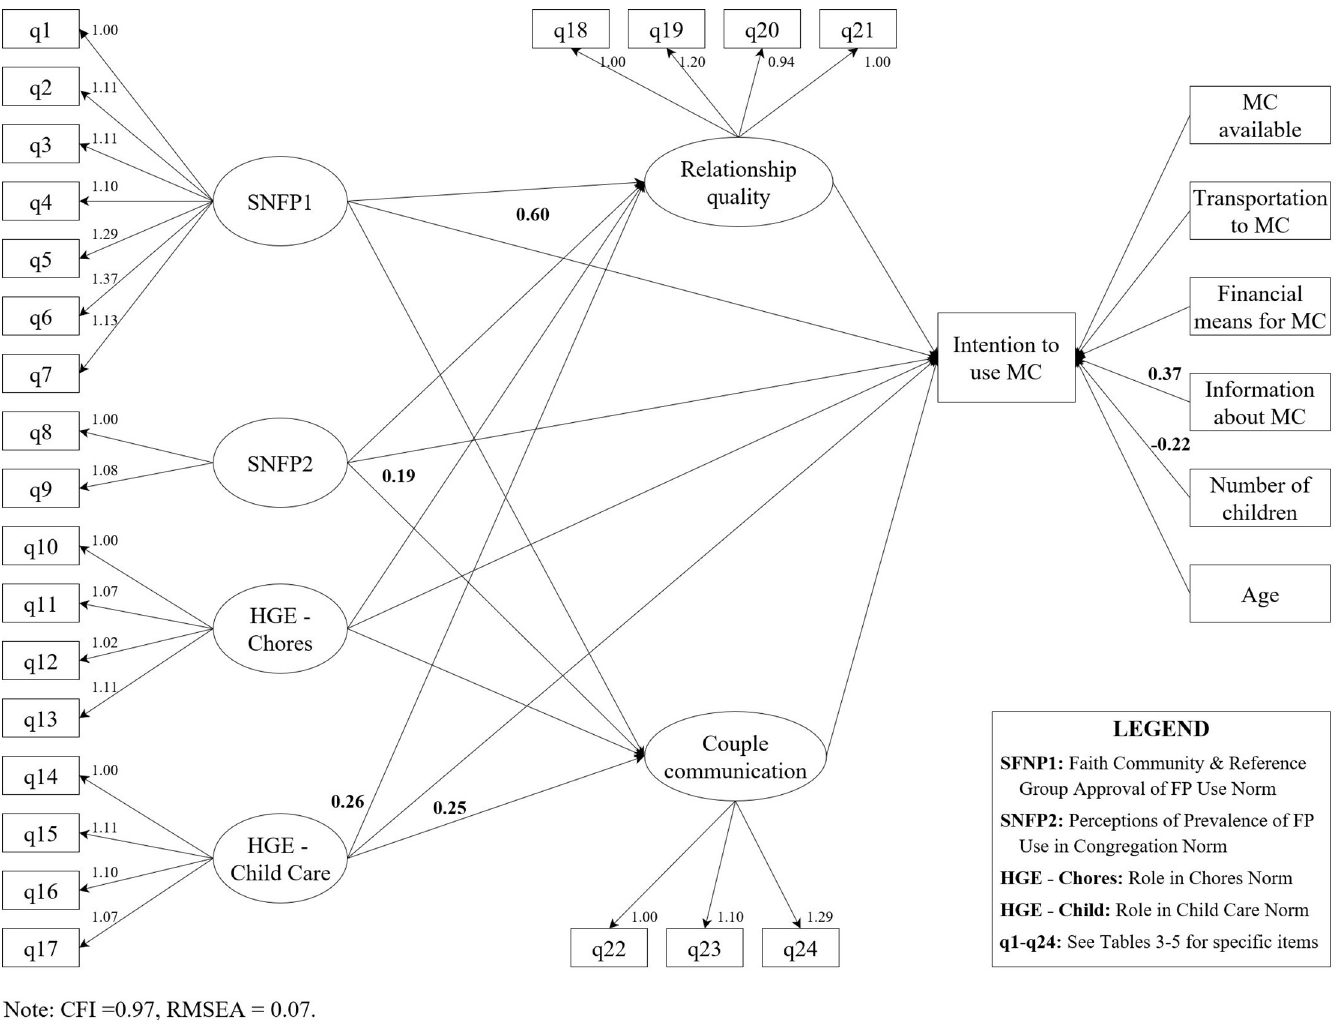
Fig 2. Structural equation model for the association of social norms with intention to use a modern contraceptive method among women, Kinshasa, DRC